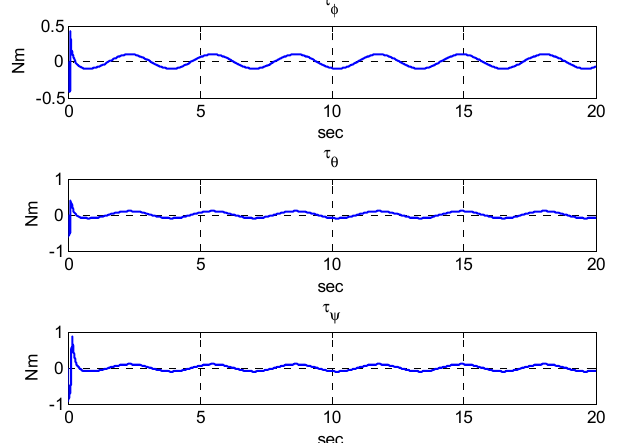
Figure 12. The turning torque with variable deviations and perturbations.